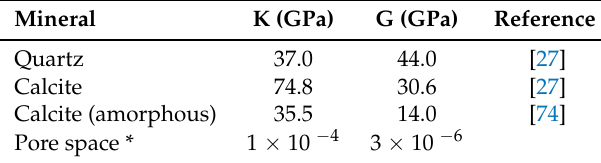
Figure 4. Effective elastic properties are calculated using the stress-strain behaviour of the normalized digital rock sample. For that purpose, a small strain is applied at one boundary face (z = 1), while roller boundaries fix the displacements perpendicular to its opposite face (z = 0) and two adjacent boundaries (x = 0, y = 0). Table 1. Bulk (K) and shear (G) moduli for selected minerals to compute effective elastic